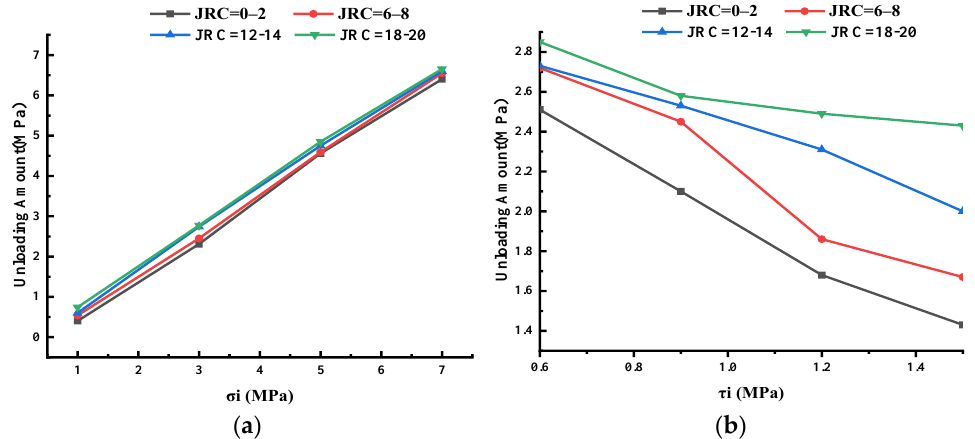
Figure 13. Unloading amount and initial stress. ( a ) Unloading amount and initial normal stress. ( b ) Unloading amount and initial shear stress.